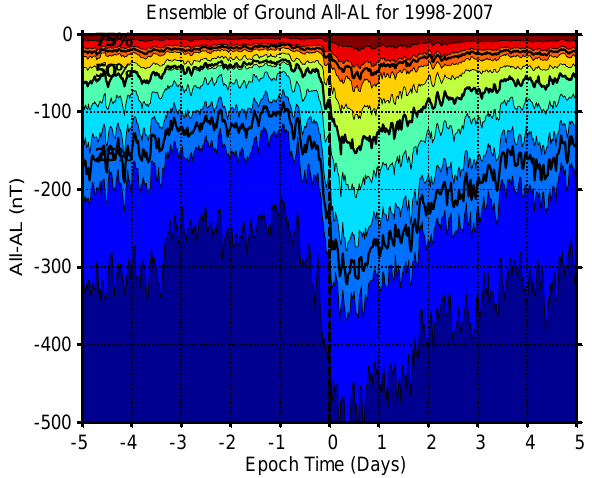
Figure 5. A dynamic cdf of the AL index relative to stream interface (vertical dashed line) within a CIR is presented. Heavy lines are the quartiles as a function of epoch time. Note that the minimum AL index is more negative than -300 nT about 25 % of the time.